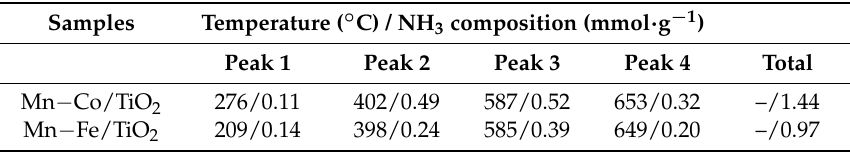
Table 3. Quantitative analysis of NH 3 -TPD